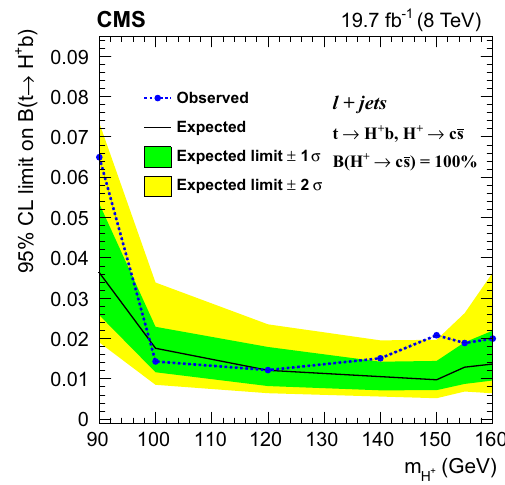
Fig. 20 CMSexclusionlimitonthebranchingfractionBR ( t → H + b ) as a function of M H ± assuming BR ( H + → c ¯ s ) = 100%. (Reprinted with kind permission from JHEP and the authors, Fig. 6 of [215])